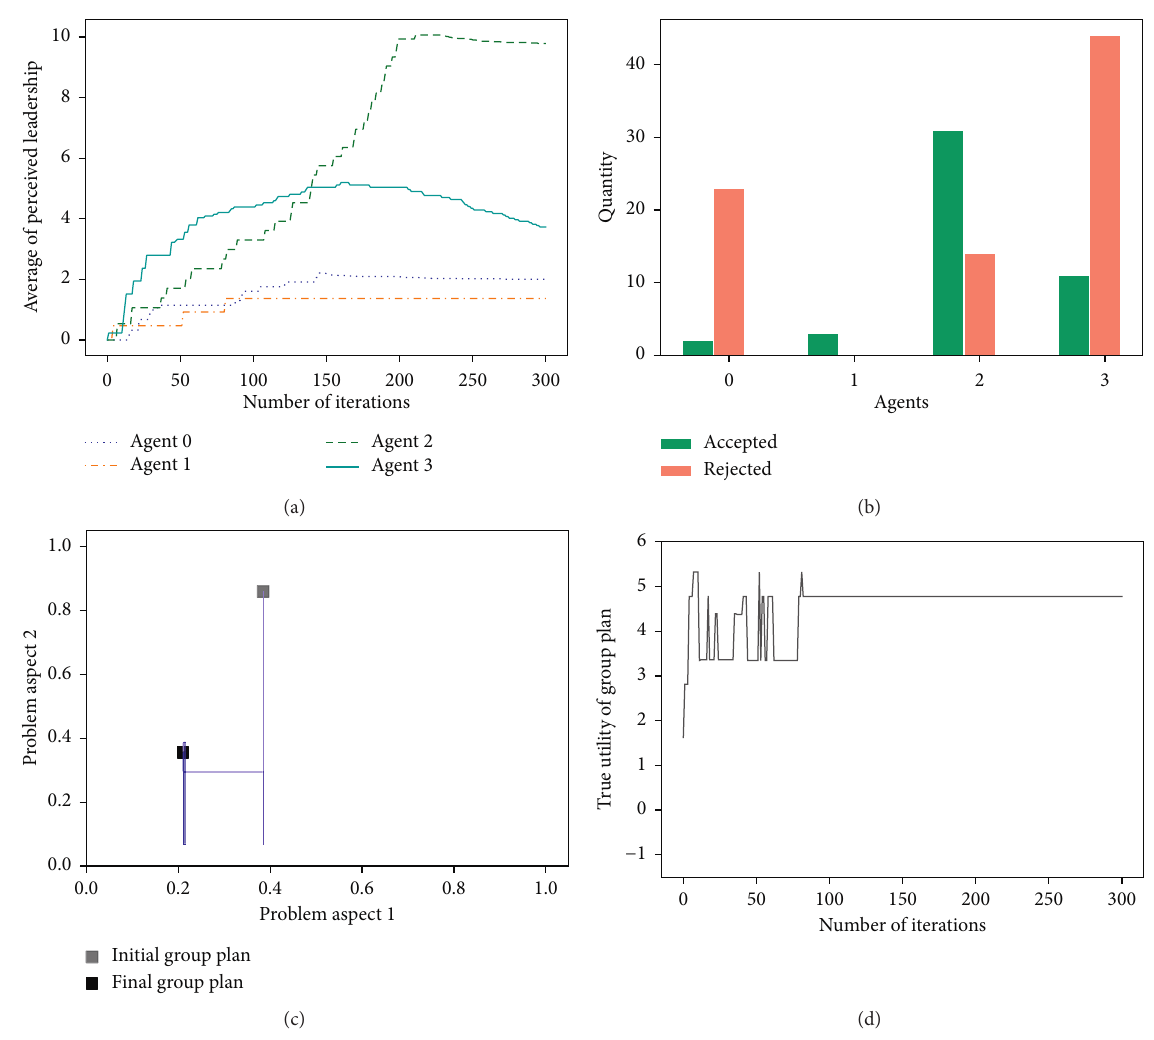
Figure 3: Simulation results of the representative 4-agent group. (a) Dynamical change of the agents’ perceived leaderships. The average of each agent’s perceived leadership is shown in this plot. (b) Quantities of adopted and rejected plans proposed by each agent. (c) The trajectory of the group plan. (d) The change of the group plan’s true utility. Note that agents’ attributes are defined in Table